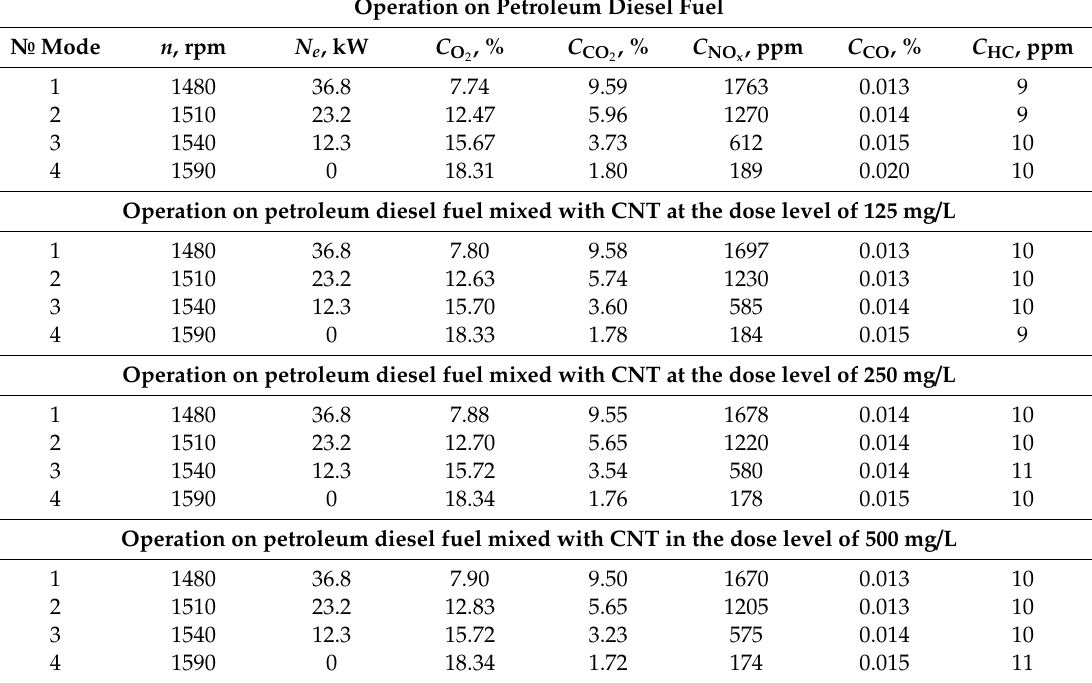
Table 4. The results of exhaust gas emission of the D-243 diesel engine when operating according to the regulatory characteristic. Engine crankshaft speed n , e ff ective power N e , volume concentration of oxygen in exhaust gas C O , carbon dioxide emission C CO , nitrogen oxides emission C NO , carbon 2 2 x monoxide emission C CO , and hydrocarbon emission C HC